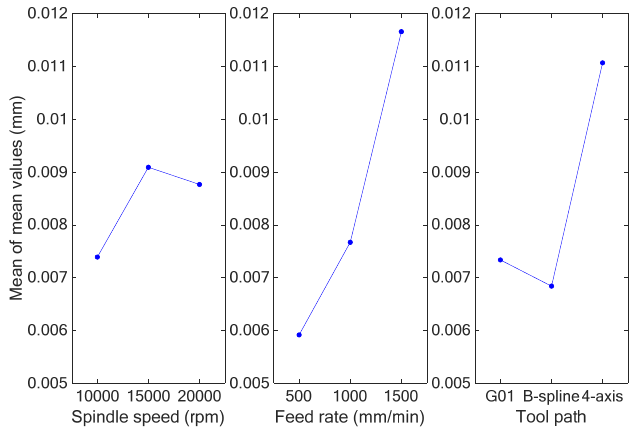
Figure 19. Graph of mean values for profile errors.